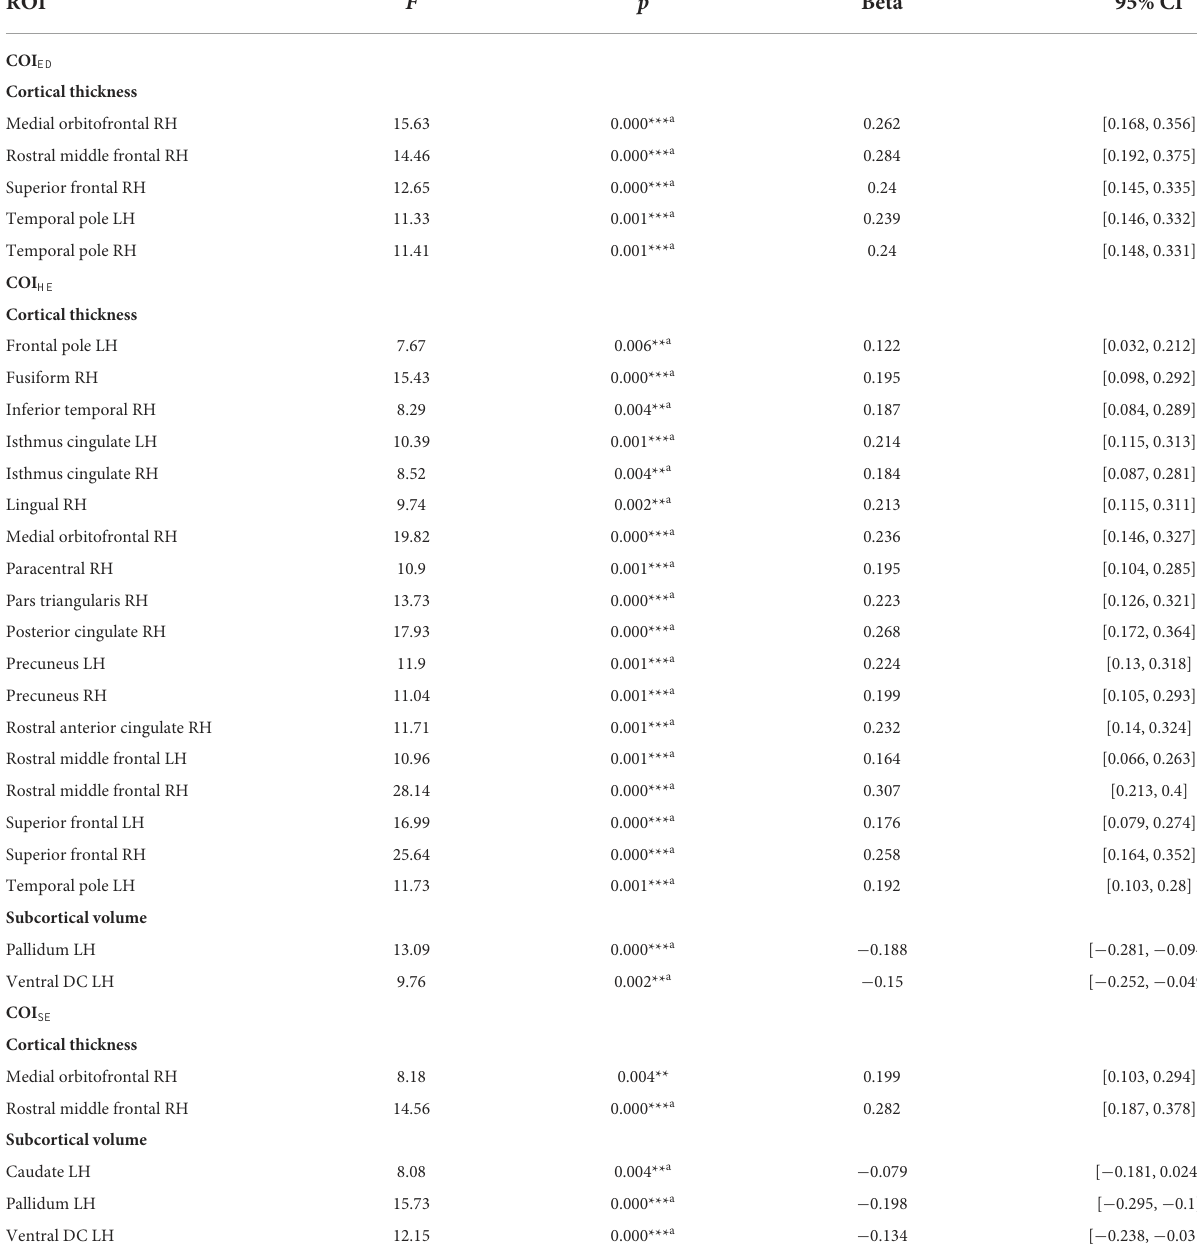
TABLE 4 Brain regions that showed two-way interactions with each domain of the child opportunity index